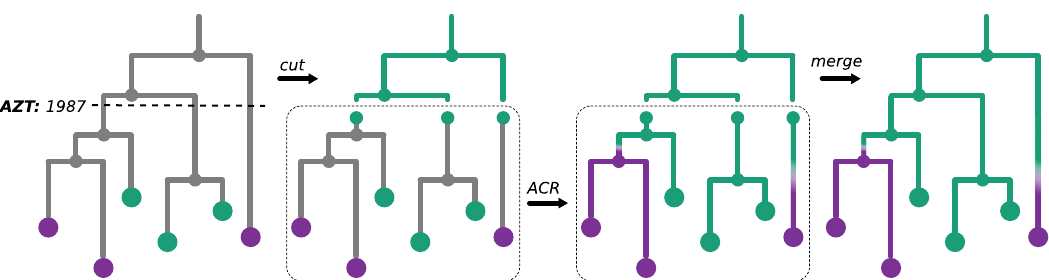
Fig 7. ACR for DRMs. To reconstruct the ancestral character states, resistant (violet) or sensitive (light-green), for a DRM (e.g. RT: M41L), we cut the time-scaled tree at the date of introduction to Cuba of the first ARV (as, for example, AZT for the DRM RT:M41L, used in Cuba since 1987) that can provoke this DRM (left panel), obtaining the pre-treatment-introduction tree (upper part of the tree) and a forest of post-treatment-introduction subtrees (bottom part). For the trees in the forest we then marked their roots as sensitive (middle left panel). We performed the ACR with PastML on the forest (middle right panel) and combined the results with the the all-sensitive annotation for the pre-treatment-introduction tree nodes (right